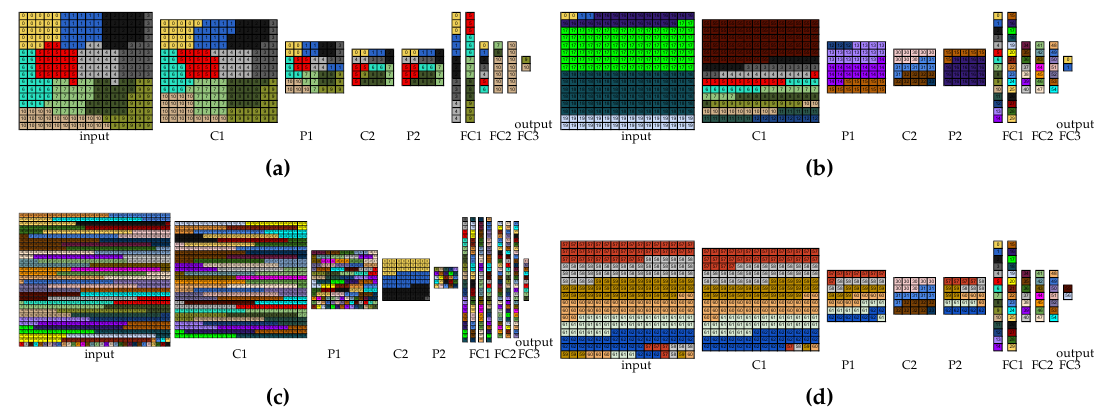
Figure 6. Partitionings using the inference rate greedy approach: ( a ) LeNet 2:1 for the 11-device experiments; ( b ) LeNet 2:1 for the 56-device experiments; ( c ) LeNet 1:1 for the 56-device experiments; ( d ) LeNet 2:1 for the 63-device